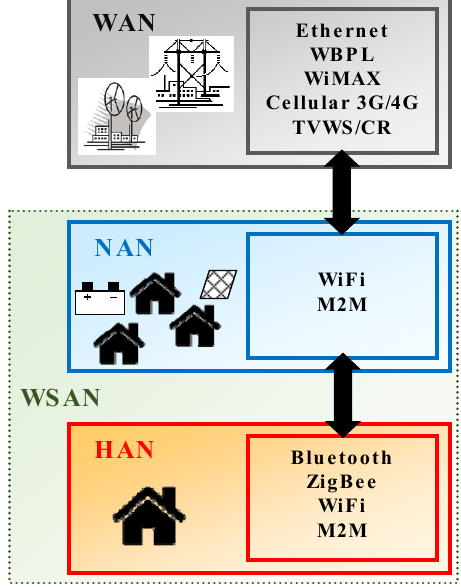
Figure 7. The proposed communication technologies for each level of the SG.